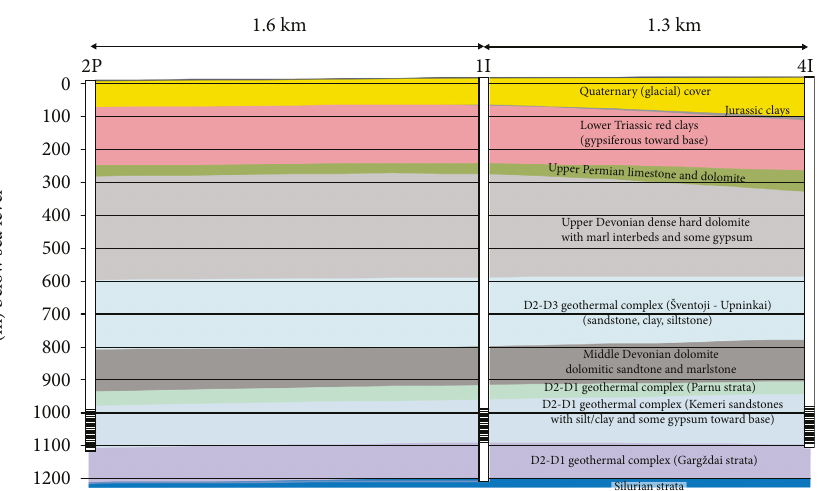
Figure 2: Geological section of Klaipeda geothermal well fi eld (as constructed), showing locations of well screens (each screen represented may represent several discrete screened sections within the interval). 2P and 3P are in the NW and 4I in the SE. Based on information in [16] and drilling logs [12 –